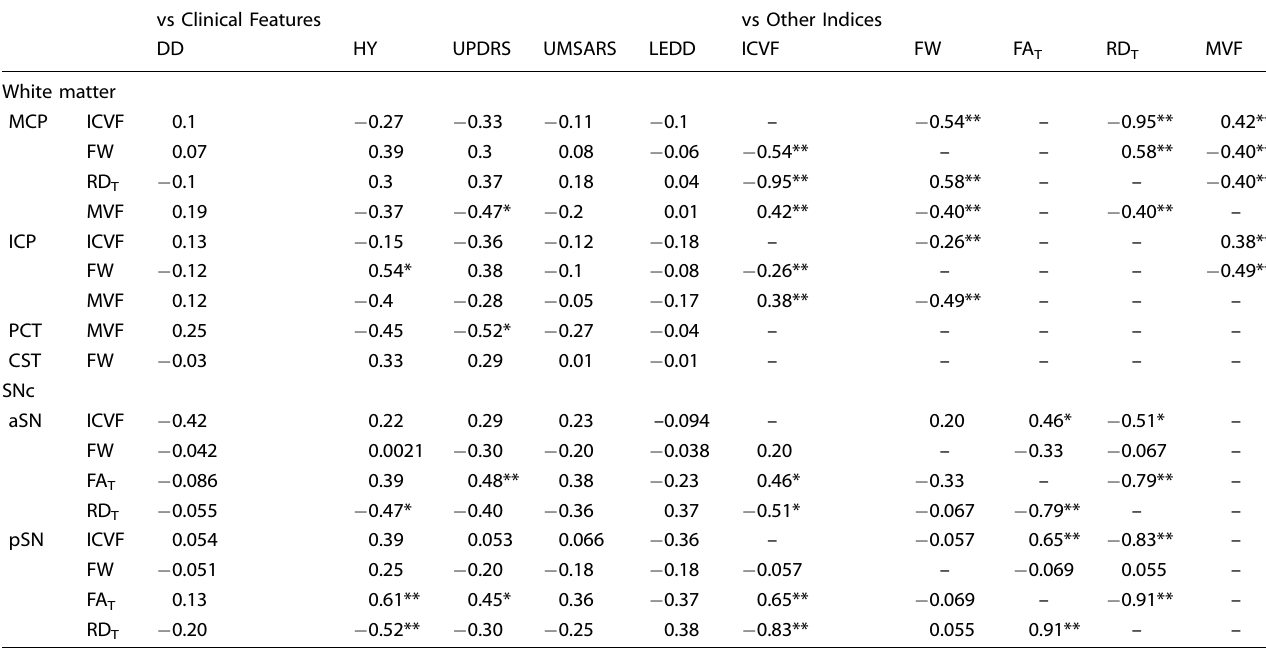
Table 2. Spearman rank correlations between signi fi cant regions in the ROI analysis and clinical features or MR indices in the fi rst cohort. vs Clinical